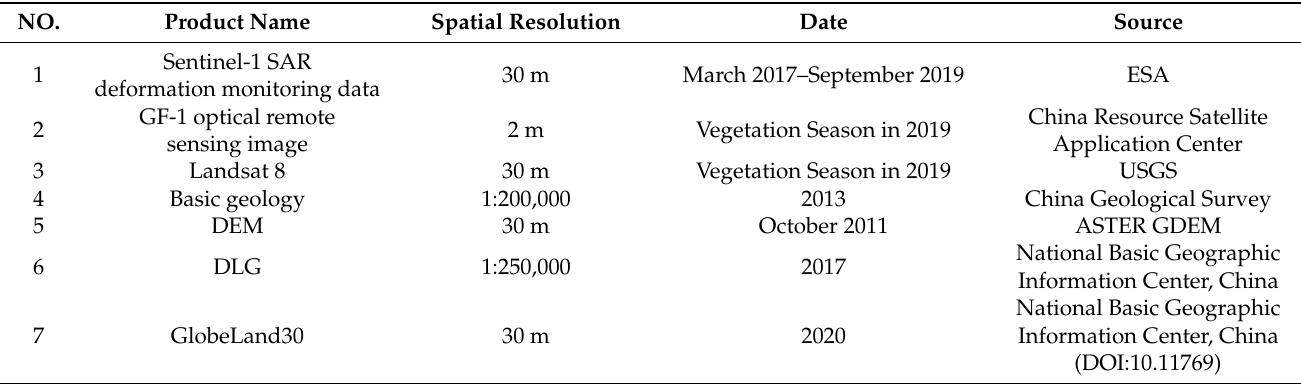
Figure 3. Deformation Results of the Descending Orbit. Based on the multi period Sentinel-1 data and Gaofen-1 optical image in the data list of Table 1, the temporal InSAR processing method and human–computer interactive in- terpretation method based on expert experience were used respectively to obtain the spa- tial distribution of deformation accumulation area and suspected active landslide hazards in the study area. In order to ensure the identification accuracy of active landslide hazards in the study area, the study introduced overlapping area inspection and external observa- tion calibration in the process of time series InSAR data processing, and carried out field verification on the identification results of 23 suspected active landslide hazards, of which 16 were identified as active landslide hazards, and the overall identification accuracy of active landslide hazards in the study area was 69.57%, which shows that the potential active landslide hidden danger data obtained has reached a high accuracy, because what the study focused on is not occurred landslides, but the discrimination and prediction of the potential landslide hidden danger that has not yet occurred. Then, based on the new